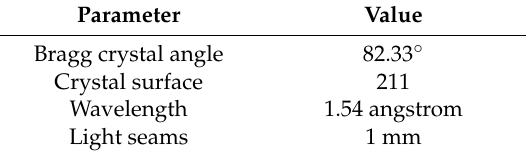
Figure 3. Residual measurement device and measurement locations on the specimen.